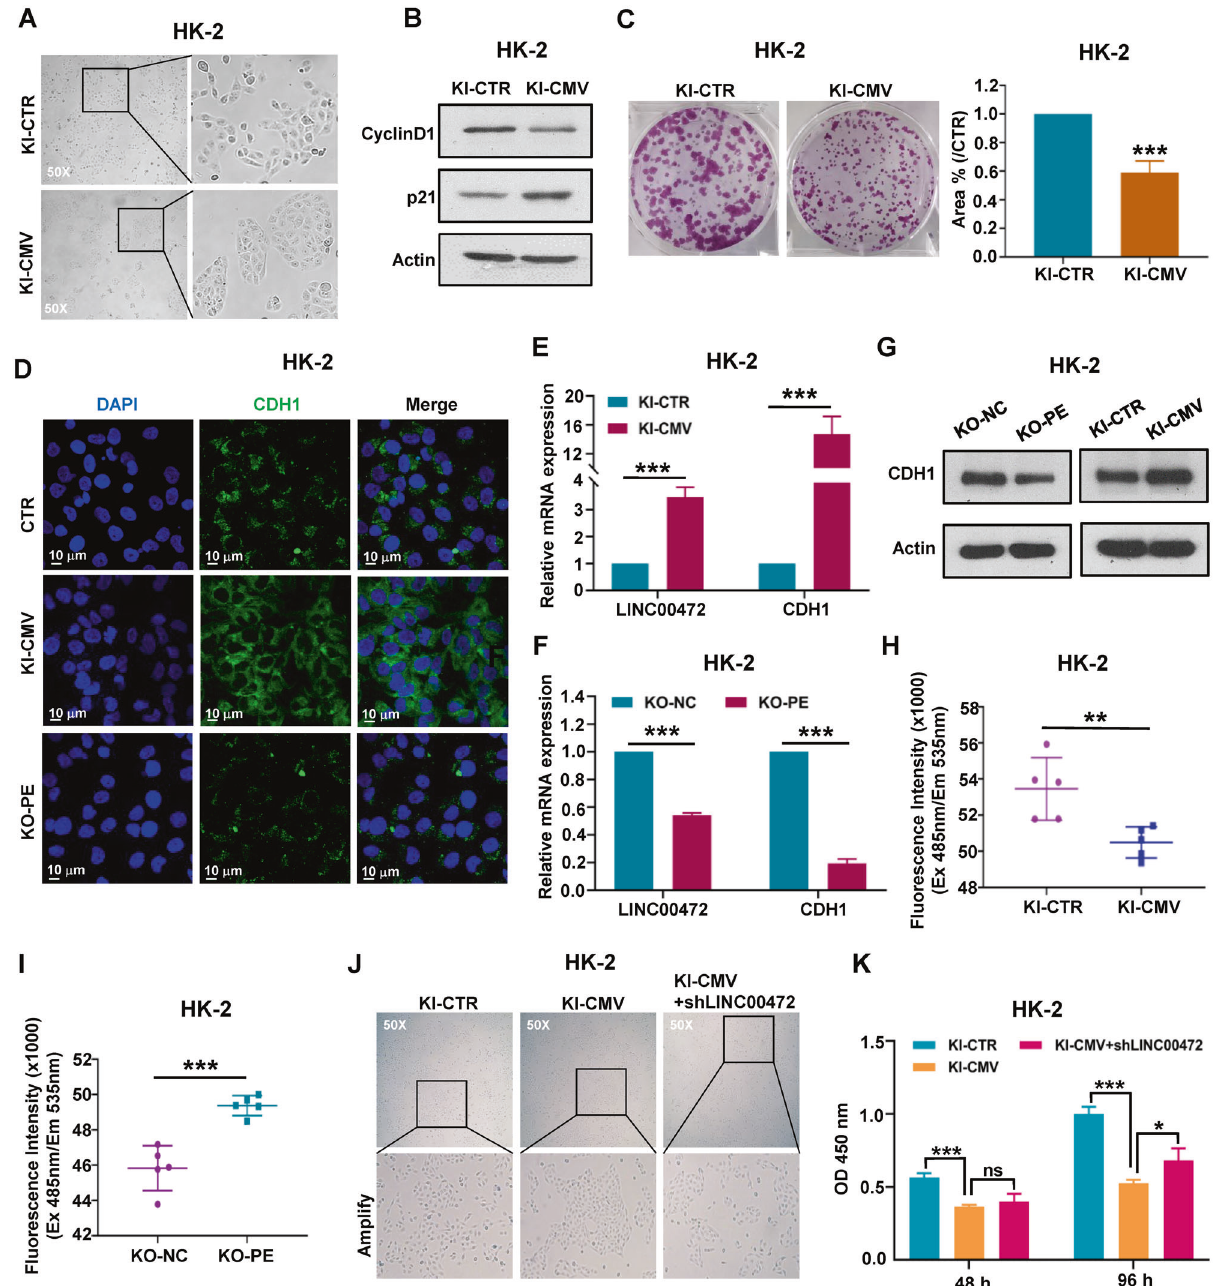
Fig. 5 Overexpression of LINC00472 inhibited cell proliferation and enhanced intercellular connectivity. A The cell growth morphology of LINC00472 overexpression cell line (HK-2 KI-CMV) and control cell line (HK-2 KI-CTR) were observed by fl uorescence microscope. B Western blot was used to detect the levels of Cyclin D1 and p21 protein in HK-2 KI-CMV and HK-2 KI-CTR cell line. C Single cell clone formation assay of HK-2 KI-CMV and HK2 KI-CTR cell line (Left). Statistics of clone formation Area (Right). D The distribution of CDH1 were detected by immuno fl uorescence. The expression of CDH1 was detected by using RT-qPCR in HK-2 KI-CTR/HK-2 KI-CMV cell line ( E ) and HK-2 KO-NC/HK-2 KO-PE cell line ( F ). G Western blot was used to detect CDH1 protein level. H , I Monolayer cell permeability test is used to re fl ect the tightness of intercellular connections. The molecular permeability of LINC00472 high expression group was signi fi cantly lower than that of control group ( H ), while the molecular permeability of LINC00472 low expression group was evidently higher than control group ( I ). J HK-2 KI-CMV cell line was transfected with LINC00472 lentivirus interference vector (HK-2 KI-CMV/shLINC00472), and the cell growth morphology were observed by fl uorescence microscope. K Cell Counting Kit-8 test was used to detect the proliferation of HK-2 KI-CTR, HK-2 KI-CMV, and HK-2 KI- CMV/shLINC00472 cell lines. In C, E , F , H, I , and K , data were shown as mean ± SD of three independent experiments (* P < 0.05, ** P < 0.01, *** P < 0.001, ns non-signi fi cant).